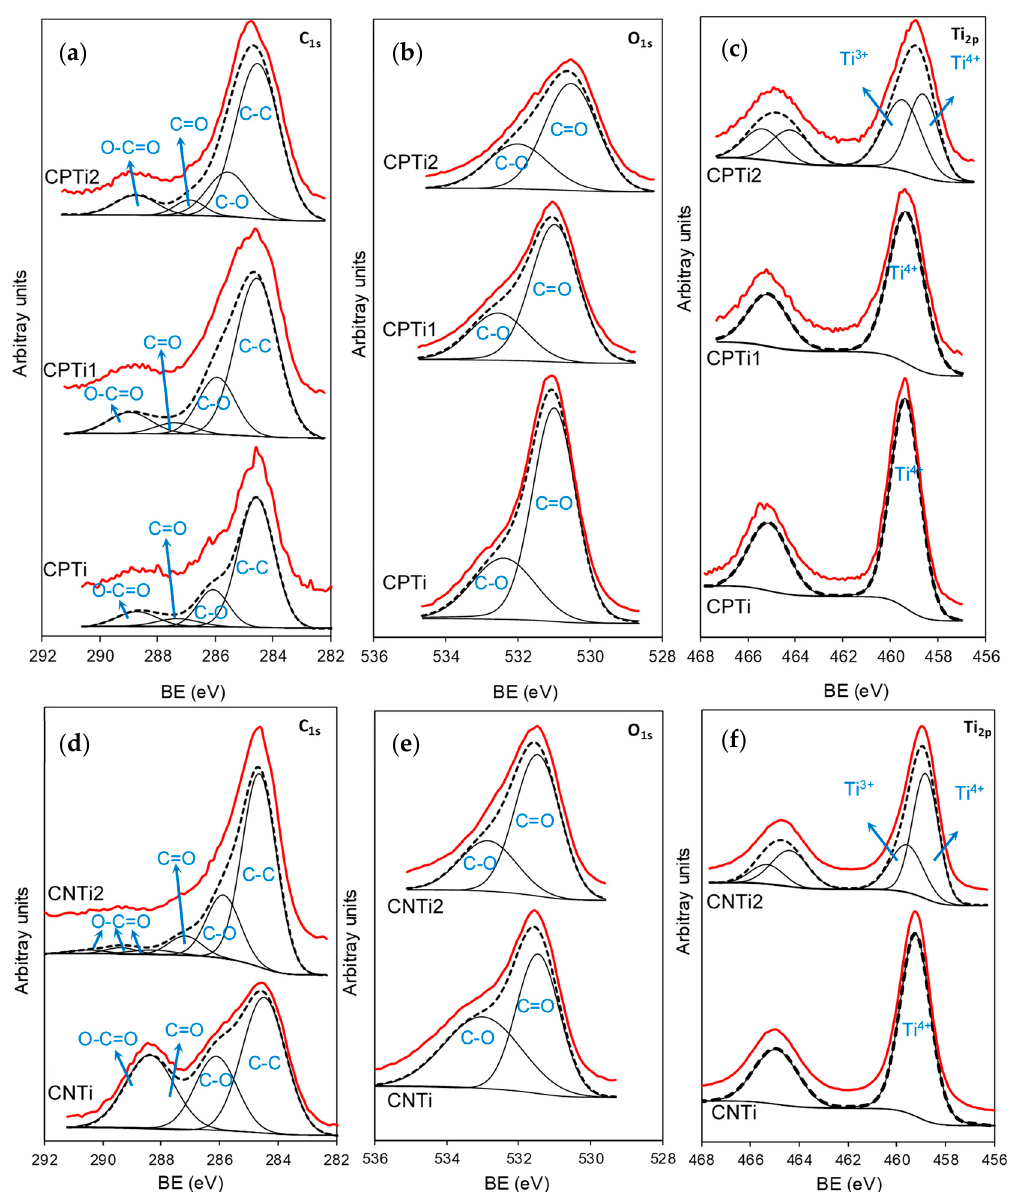
Figure 2. High-resolution XPS spectra of the C1s ( a , d ), O1s ( b , e ) and Ti2p ( c , f ) regions for Ti-impregnated cellulose derivatives and their corresponding carbonized composites.